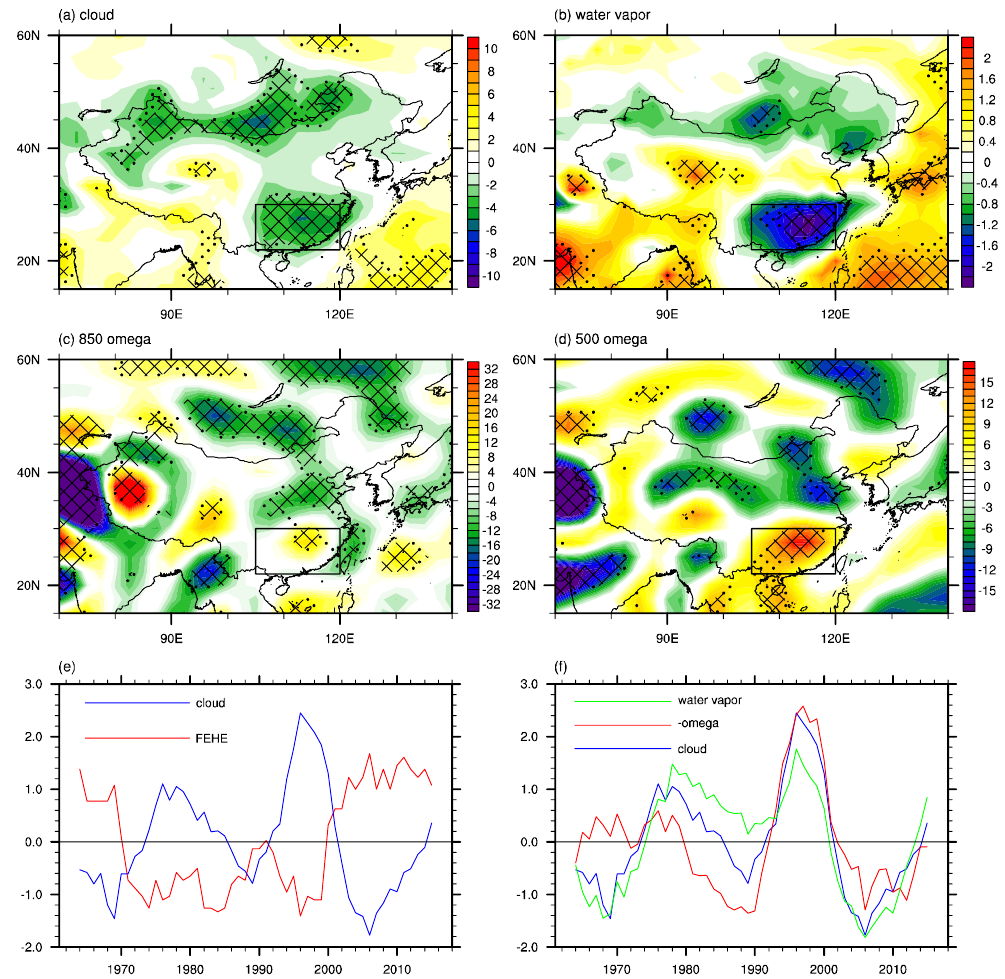
Figure 6. The differences in the summer mean ( a ) total cloud amount (unit: %), ( b ) atmospheric water vapor content (unit: kg m − 2 ), (c) 850–hPa vertical velocity (unit: 10 − 3 Pa s − 1 ), and (d) 500–hPa vertical velocity (unit: 10 − 3 Pa s − 1 ) between P2 and P1 (P2 minus P1). ( e ) The standardized time series of the 7–year running mean of the regional FEHE over southern China (red) and summer mean total cloud amount (blue) averaged over southern China. ( f ) The standardized time series of the 7–year running mean of the summer mean total cloud amount (blue), atmospheric water vapor content (green) and sign-reversed 500–hPa vertical velocity (red) averaged over southern China. Dots and meshes in ( a – d ) denote where the anomalies are significant at the 90% and 95% confidence levels based on Student’s t- test, respectively. The black rectangle in ( a – d ) refers to the domain of southern China.